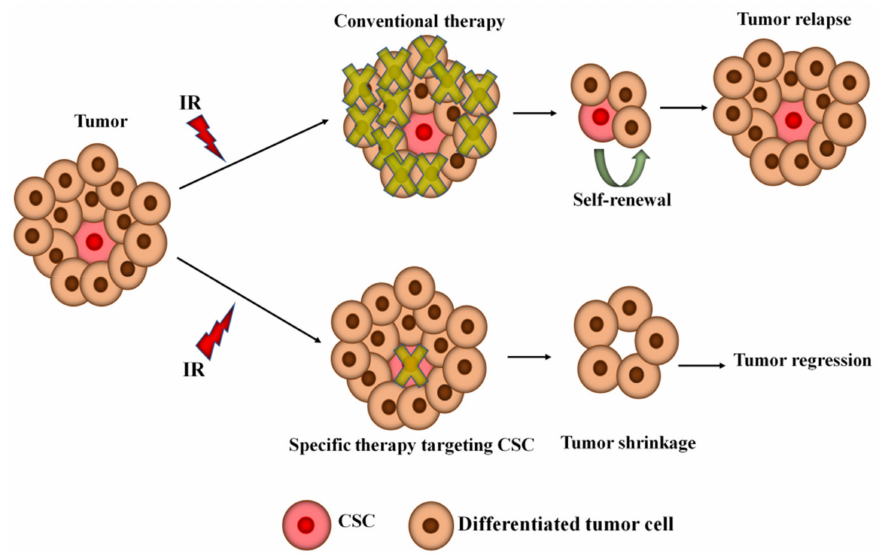
Figure 1. Targeting of CSCs. CSCs remaining after radiotherapy can then emerge and